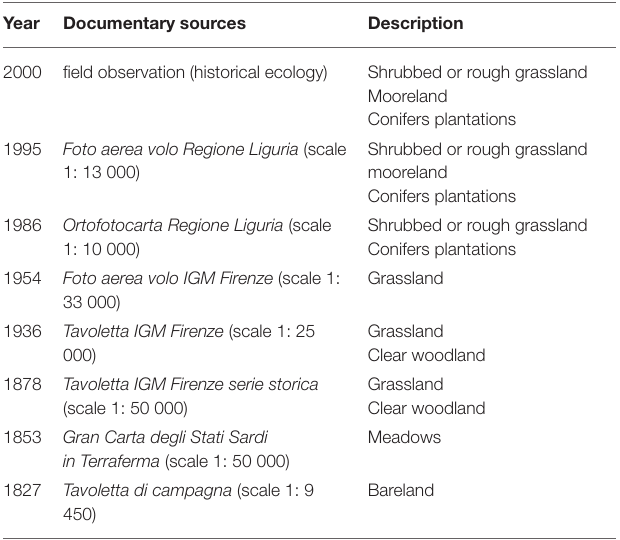
TABLE 2 | Example of “filtraggio cartografico” (topographical maps historical series: 2000-1827) for the “Pian delle Gròppere” site.